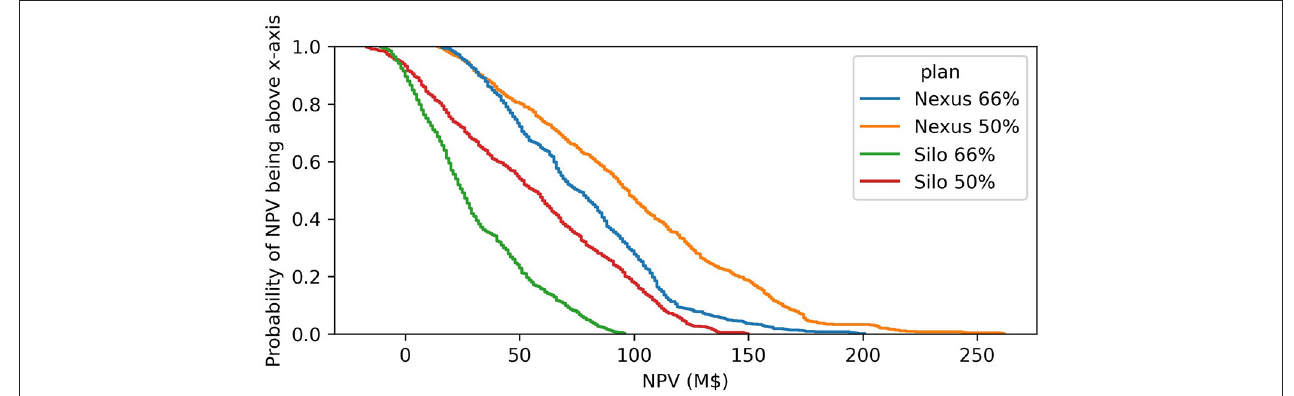
FIGURE 7 | Investment plans NPV empirical distribution function for Silo and Nexus plans. The NPV of investments plans is calculated through with-without analysis in each